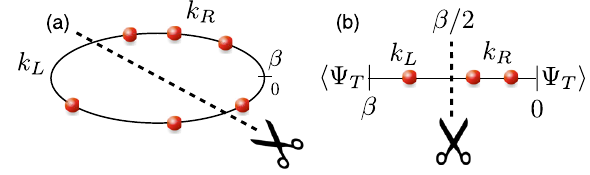
FIG. 1. Measurement of the fidelity susceptibility in the (a) nonzero-temperature formalism and in the (b) ground-state projection scheme. Each red object represents a term in the ˆ H driving Hamiltonian λ 1 , denoted as a vertex. To measure the fidelity susceptibility Eqs. (9) and (11), we divide the imaginary- time axis into two halves and count the number of vertices k L and k R , respectively. The nonzero-temperature formalism allows an arbitrary division because of the periodic boundary condition in the imaginary-time axis, while in the ground-state projection scheme the division has to be at β = 2